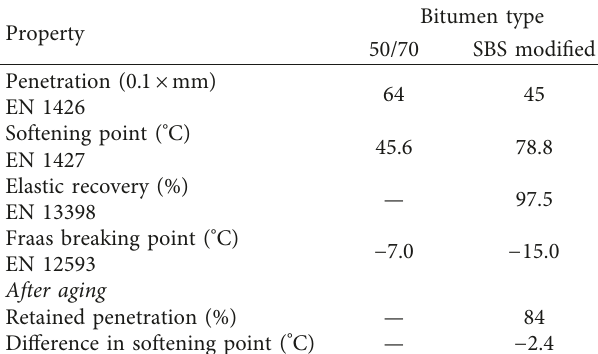
Table 2: Bitumen characteristic